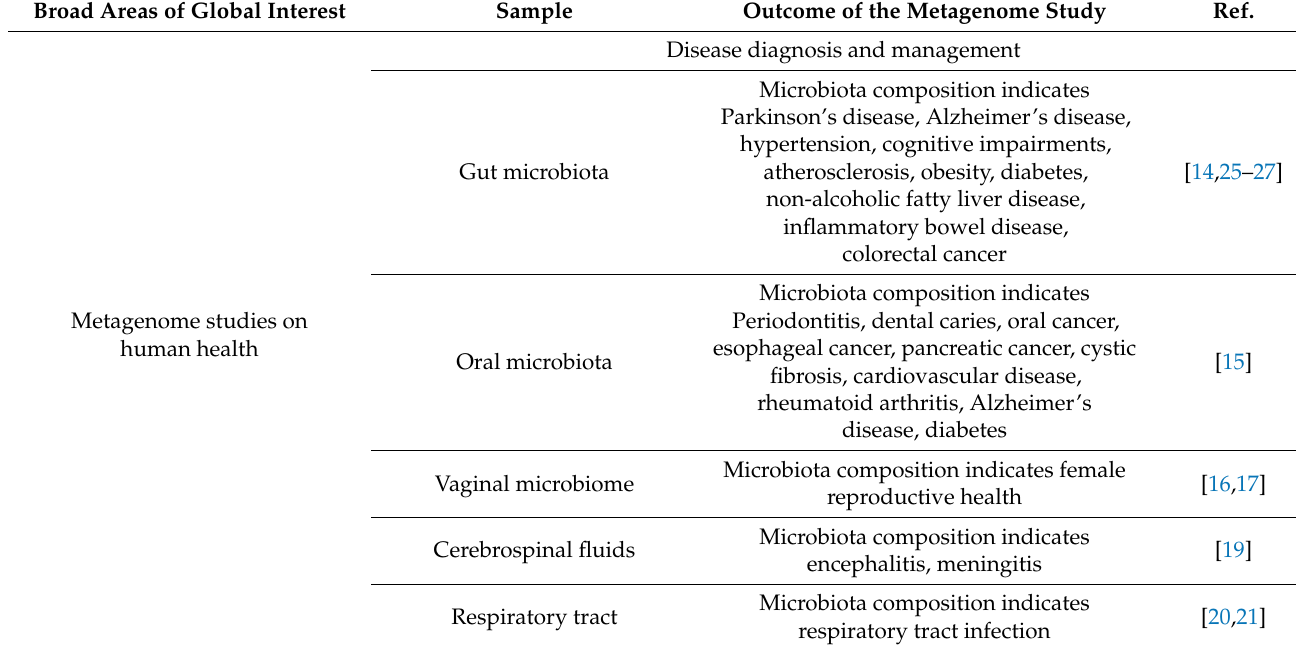
Table 1. An overview of the global focus on metagenome-based microbiome studies. Broad Areas of Global Interest Sample Outcome of the Metagenome Study